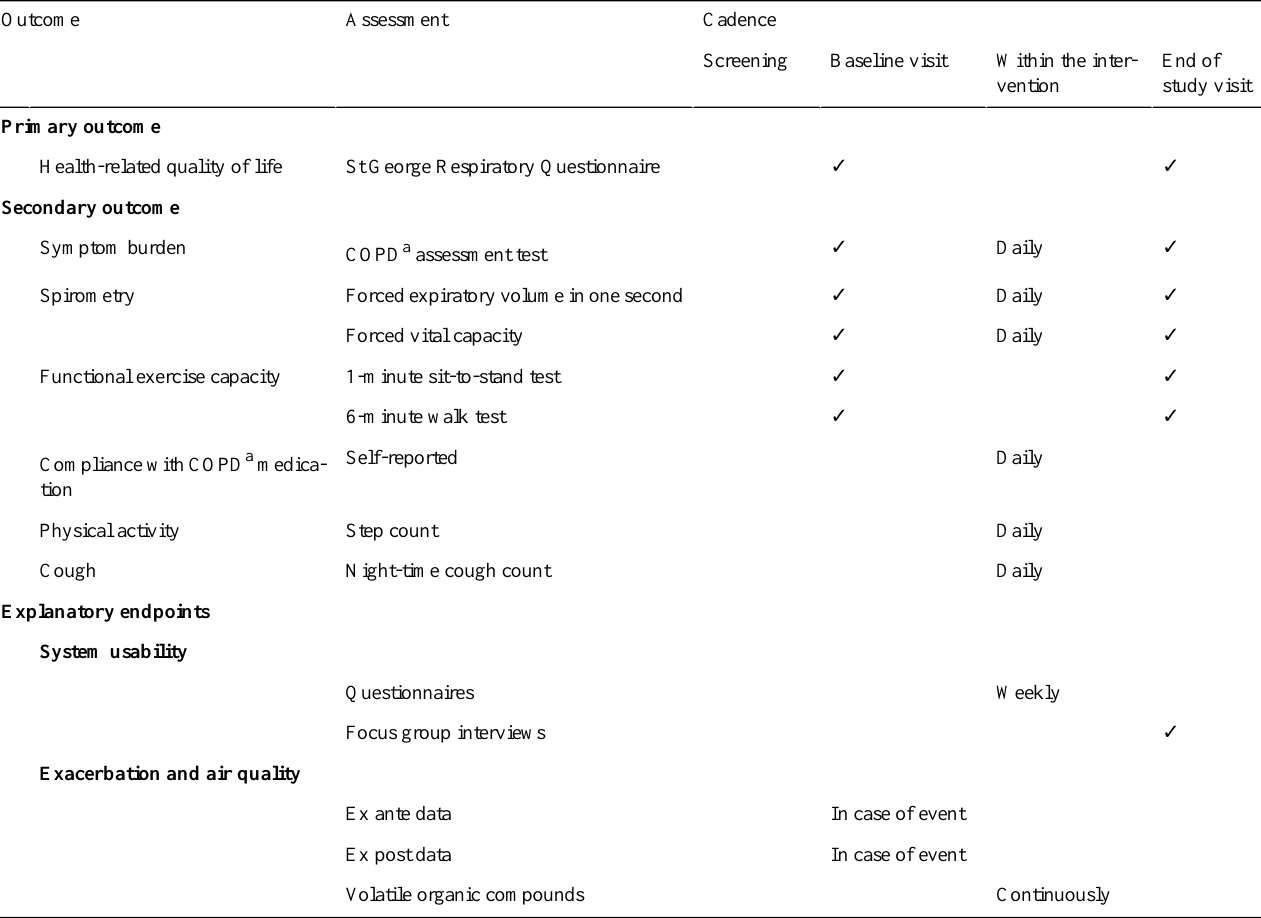
Table 1. Overview of the information collected during screening, at baseline, during the intervention and at the end of the